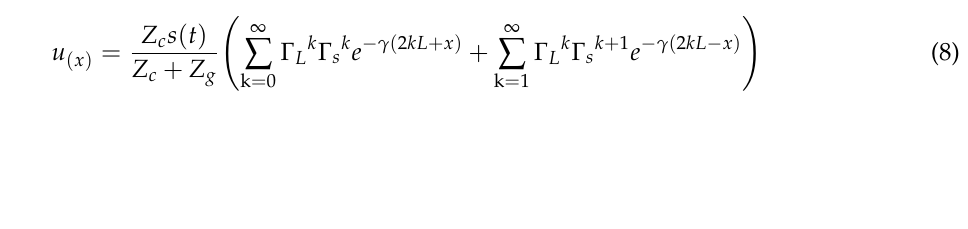
Figure 7. Equivalent circuit of inductive non-intrusive cable fault diagnosis.